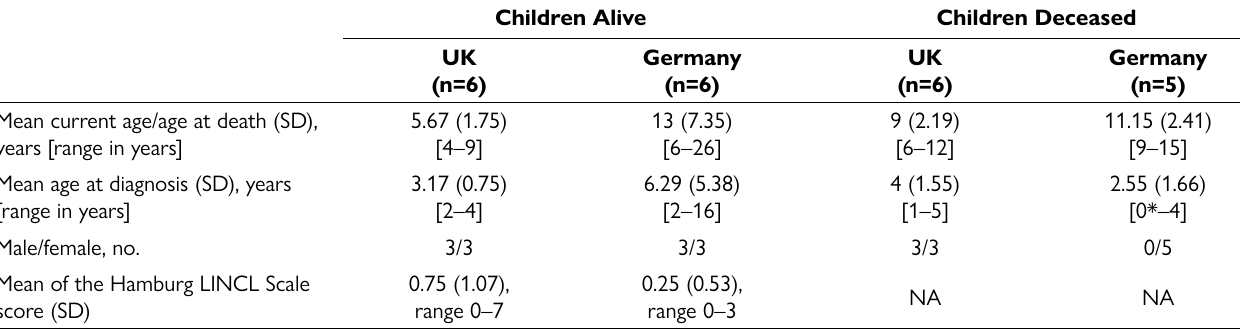
Table 4. Demographic details of the children with CLN2 disease